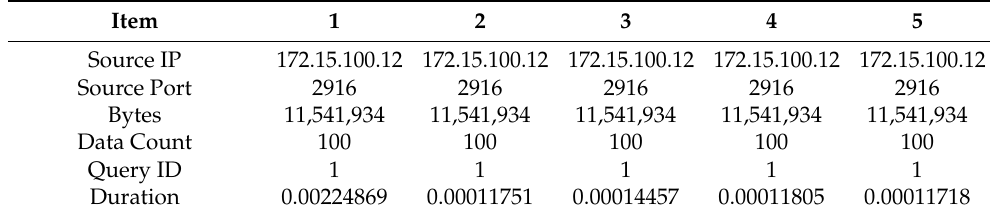
Table 13. Test results for the metadata search speed.